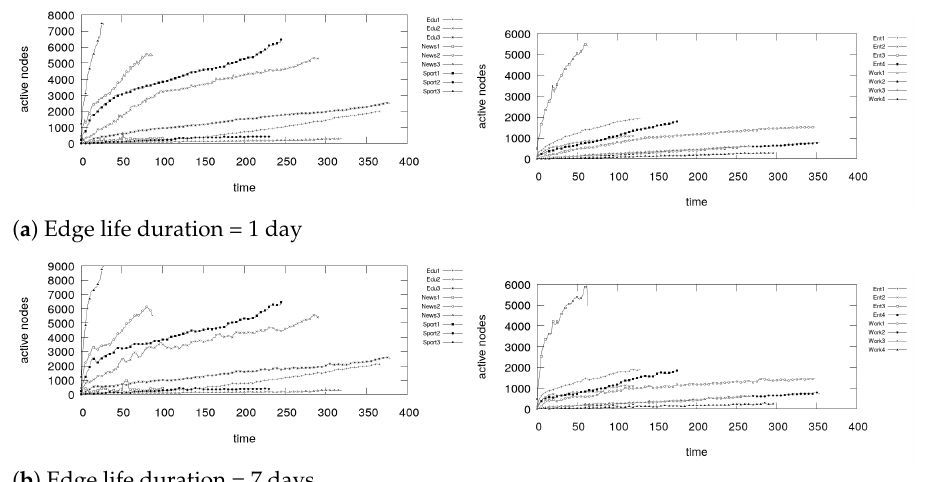
Figure 11. Number of active nodes detected by Fast Greedy.